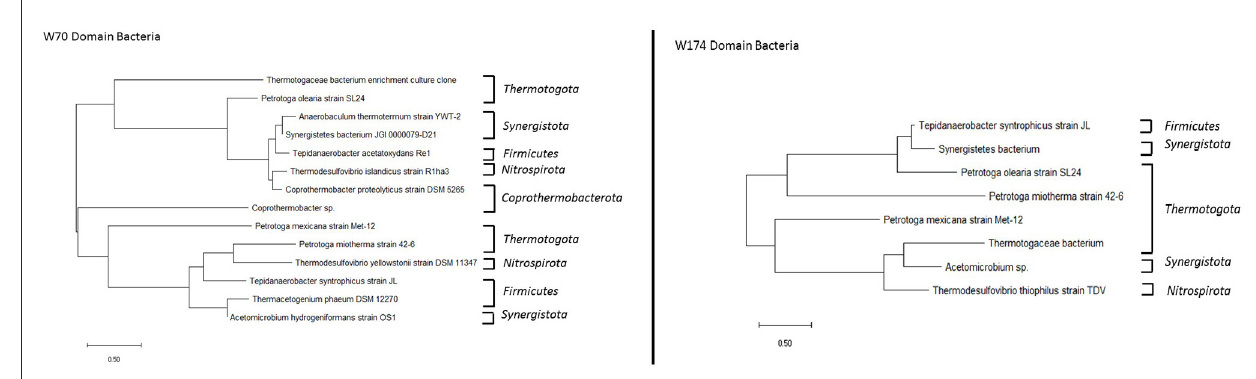
FIGURE8 Phylogenetic tree constructed using the neighbor-joining method for consortia TERIW70 and TERIW174.